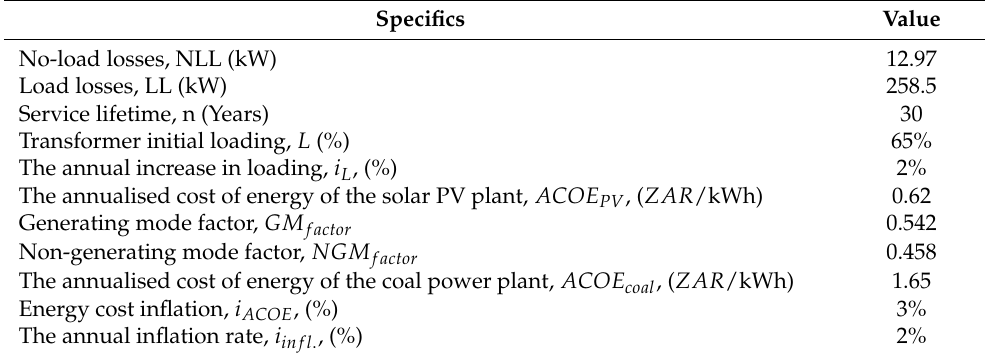
Table 1. Techno-economic specifics.